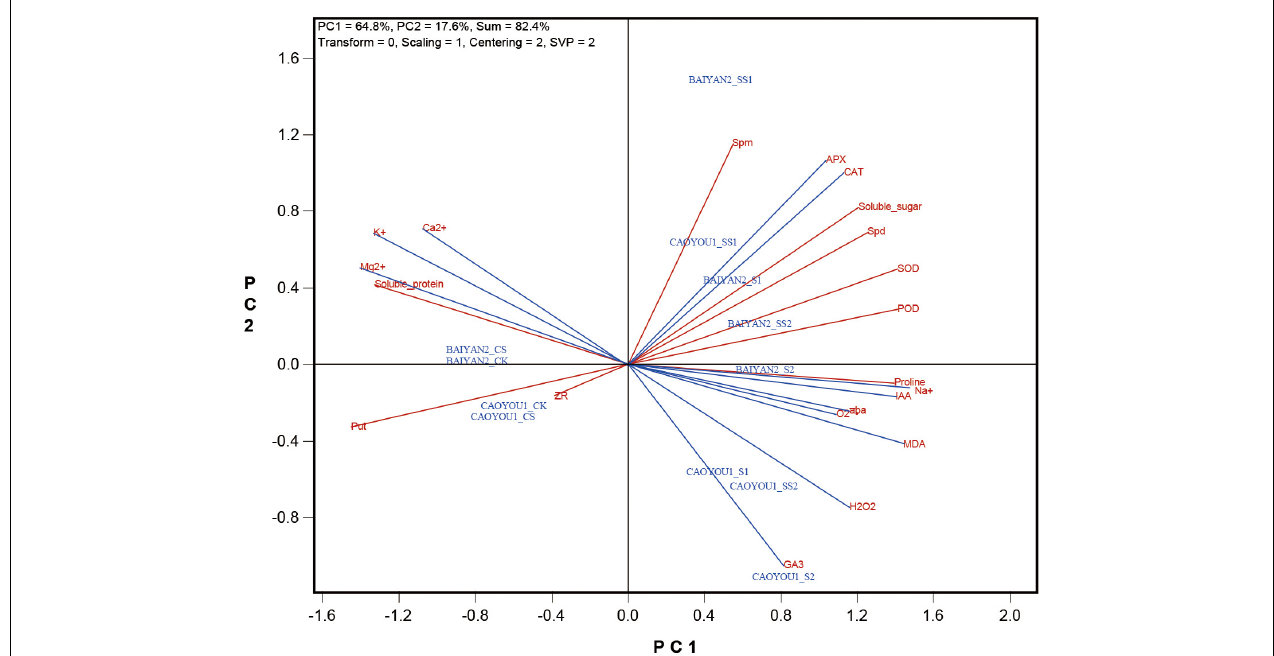
FIGURE 1 | Biplot showing the relative levels of each of the cultivar-treatment combinations for each of the determined